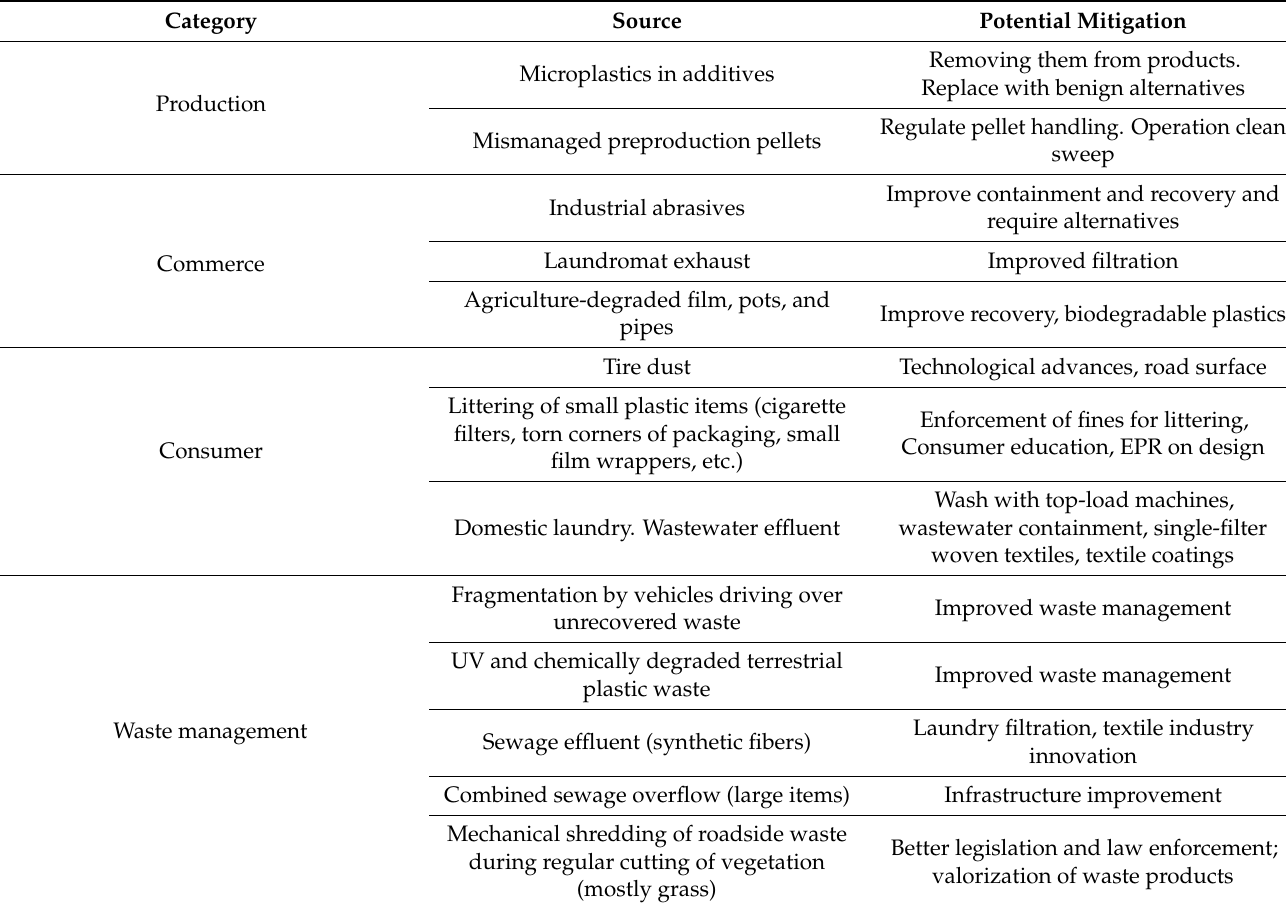
Table 1. Sources, measurements, and strategies for upstream mitigation of microplastics [62].